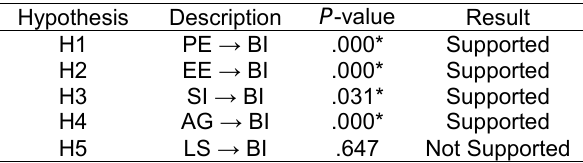
Table 4. Summary of Results